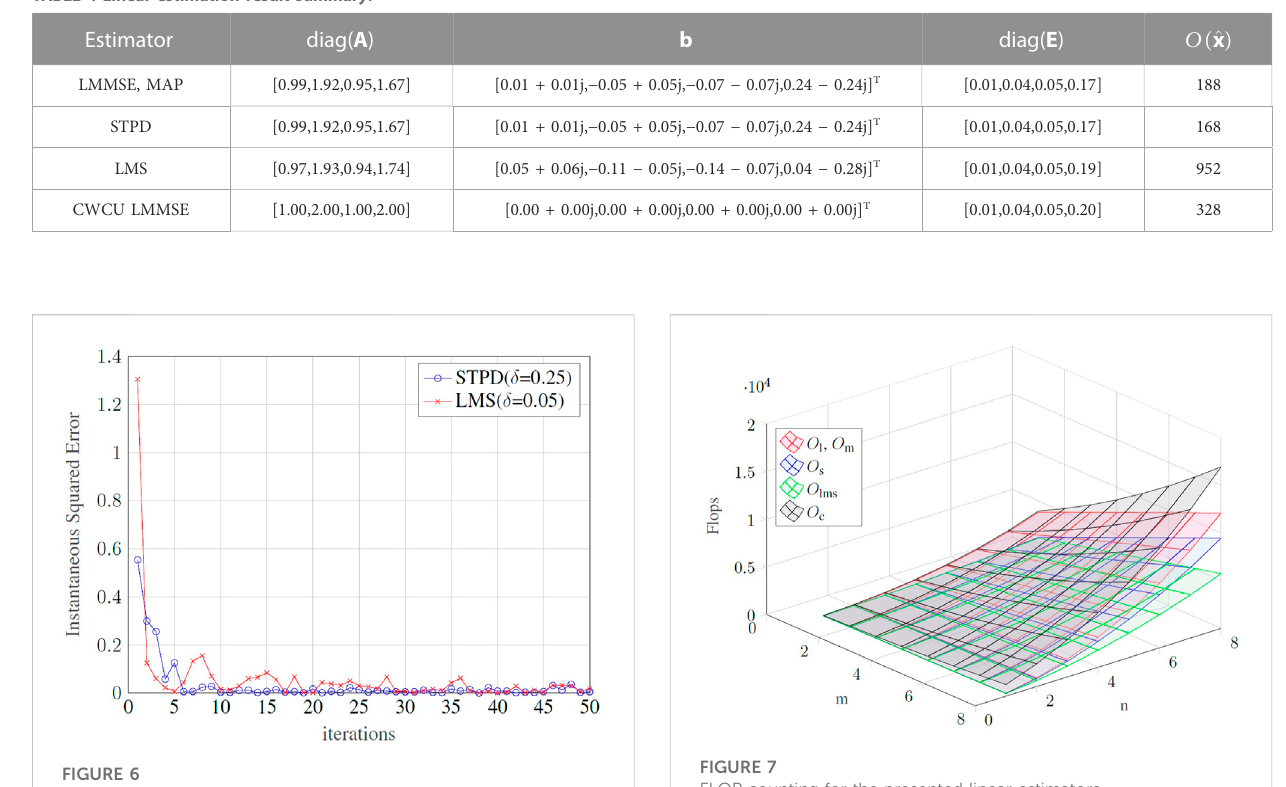
TABLE 4 Linear estimation result summary.